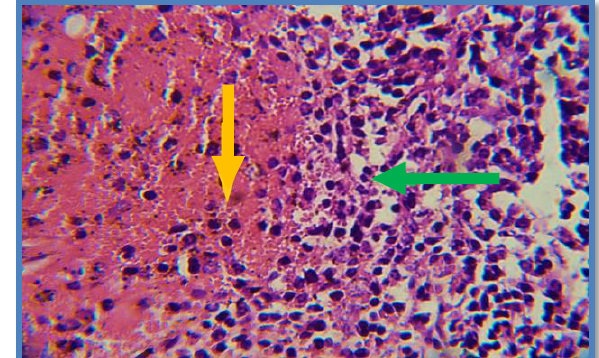
Figure, 12: Micrograph of goat group B inflammatory cells infiltration (green arrow) white and red pulp in the incision area initiated (yellow arrow) at 15 th day postoperative (H and E 40 X).